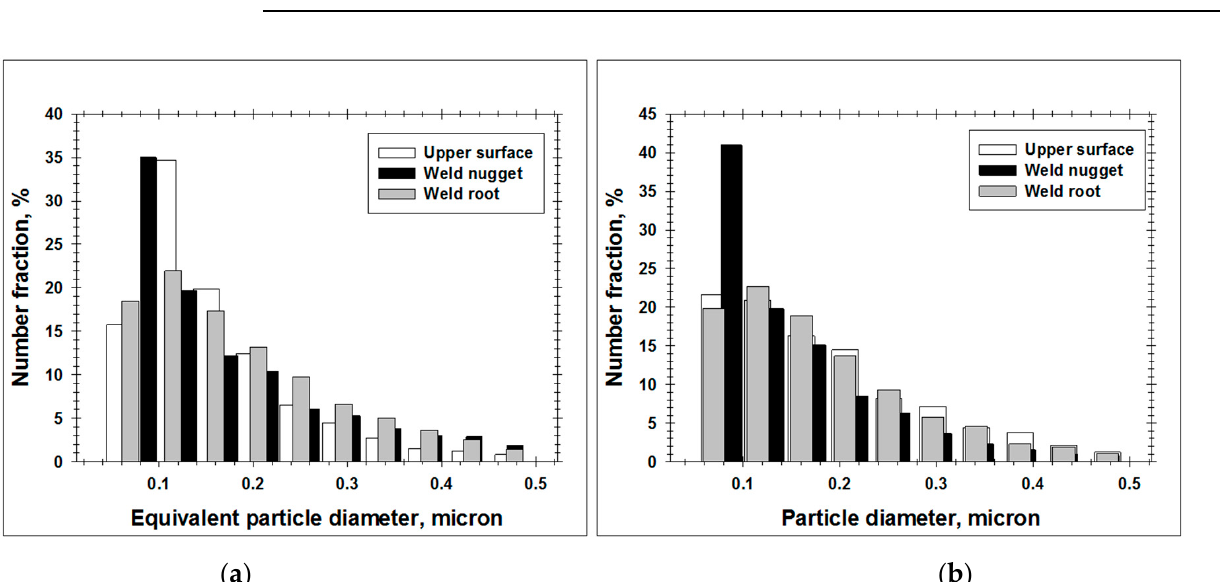
Figure 6. The precipitate-size distributions measured in different locations of ( a ) low-heat-input weld and ( b ) high-heat-input weld. The high-heat-input weld exhibited an even more complex precipitation pattern. The material at the upper weld surface had the lowest precipitation content (Table 2). Impor- tantly, the precipitates in this region were preferentially clustered along grain boundaries, being sometimes arranged as grain-boundary layers (Figure 5a). In the weld nugget, in addition to the grain-boundary precipitates, a significant fraction of the extremely fine dispersoids was also found in grain interiors (Figures 5b and 6b). As a result, this mi- crostructural region exhibited somewhat increased precipitation content (Table 2). Finally, the weld root was characterized by the largest volume fraction of precipitates (Table 2), which were evenly distributed throughout the material (Figure